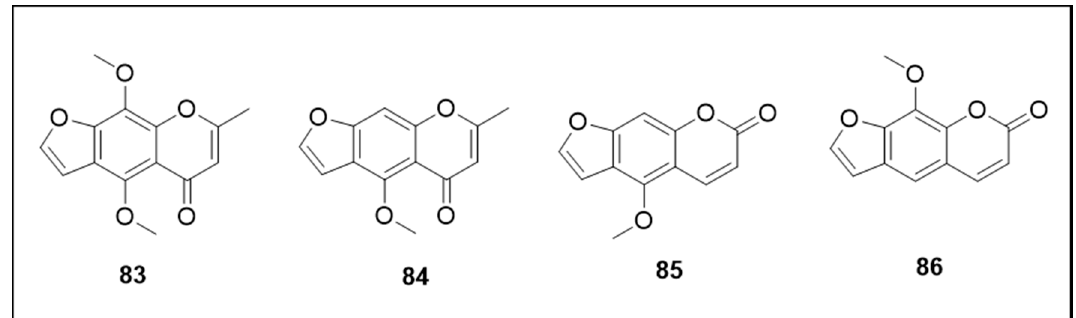
Figure 13. Furanochromones and furanocoumarins active against Ae. aegypti .